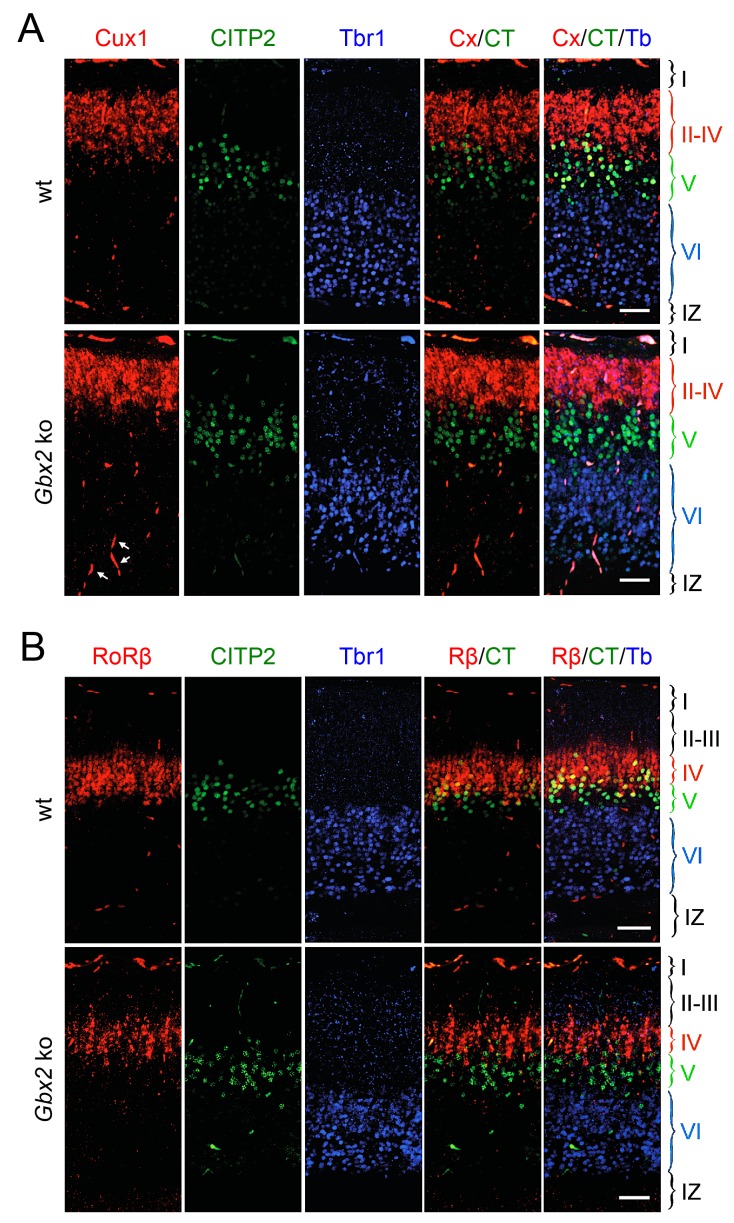
Loss of TCAs in Gbx2 knock-out mice does not affect neocortical layering at birth.Expression of cortical layer markers (Molyneaux et al., 2007) in prospective S1 cortex of newborn wild type (wt) and Gbx2 knock-out mice. (A) In situ hybridization for Cux1 (CX, a marker of layers II-IV, red) and CTIP2 (CT, a marker of layer V, green) combined with immunohistochemistry for Tbr1 (Tb, a marker of layer VI, blue). Arrows denote unspecifically labeled blood vessels. IZ, intermediate zone. Scale bar, 50 µm. (B) In situ hybridization for RoRβ (Rβ, a marker of layer IV, red), CTIP2 (green) combined with immunohistochemistry for Tbr1 (blue). Scale bar, 50 µm.